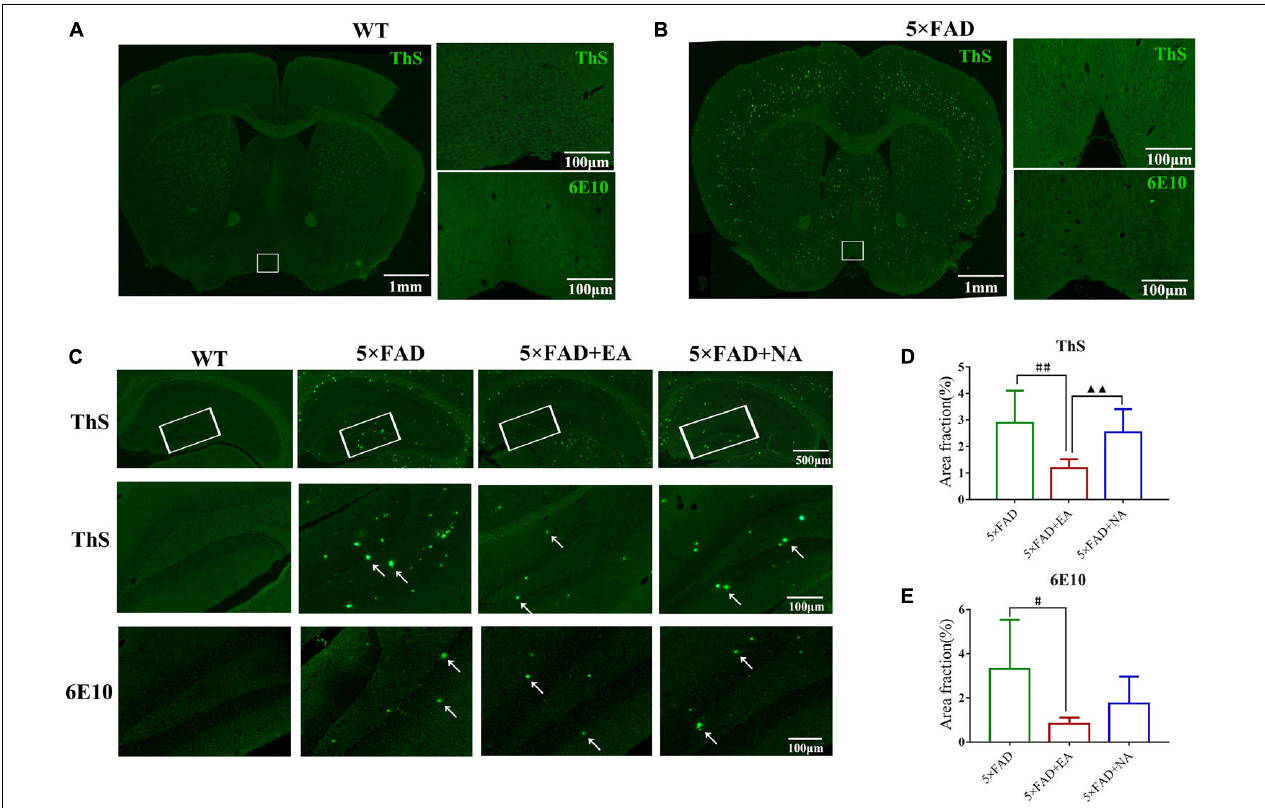
FIGURE 8 | Electro-acupuncture (EA) treatment modulates A β deposition in 5 × FAD mice. (A,B) Representative images of A β plaques in the basal forebrain (Left) and the white frame area indicate the view of the MS/VDB of WT mice and 5 × FAD mice (scale bar = 1mm). 200 × photomicrographs of Thioflavin S (ThS) and anti-A β (6E10) immunostaining in the MS/VDB were shown (Right, scale bar = 100 µ m). (C) Representative images of A β plaques in the hippocampus and the white frame area indicate the view of the DG (Top) (scale bar = 500 µ m). 200 × photomicrographs of ThS (Middle), and anti-A β (6E10) (Bottom) immunostaining in DG were shown (scale bar = 100 µ m). White arrows indicate A β plaques. (D,E) Quantitative analysis of area fraction by ThS and anti-A β (6E10). Data are represented as mean ± SD, n = 4/group ( # p < 0.05 and ## p < 0.01 vs 5 × FAD group; (cid:78)(cid:78) p < 0.01 vs 5 × FAD + EA group). ThS: Thioflavin S.